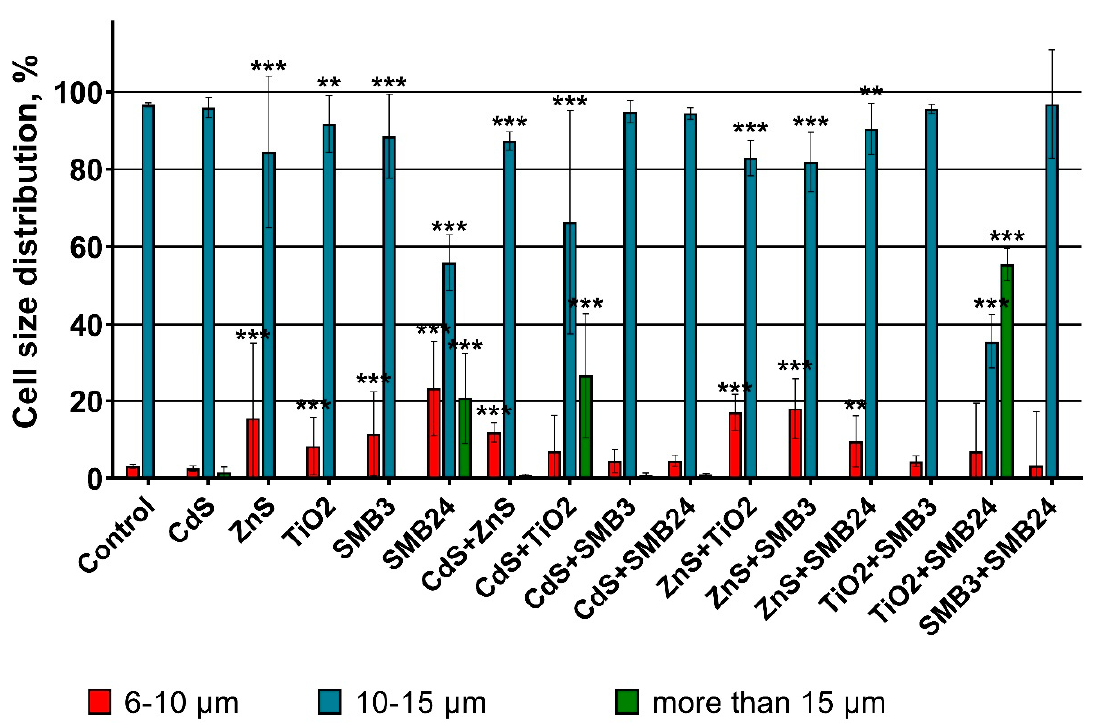
Figure 3. The changes in the size of H. akashiwo cells exposed to the single and binary mixtures of the NPs. *** p < 0.0001. ** p < 0.001.